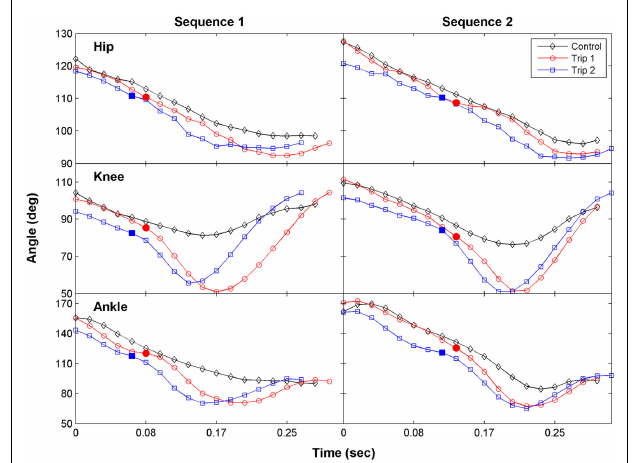
FIGURE 3 |The trajectory of the limb was changed immediately after the initial trip. (A) The trajectory of the knee (tibial head), ankle (lateral malleolus), and foot (metatarsophalangeal, MTP) for the same steps in Figure 2 are shown. (B) An expanded plot of the trajectory of the MTP during late stance and early swing of theTrip 1 andTrip 2 steps are depicted.The solid symbols in (A,B) indicate when the foot touches the trip rod. Note the earlier initiation of the swing phase inTrip 2 than Trip 1 for both